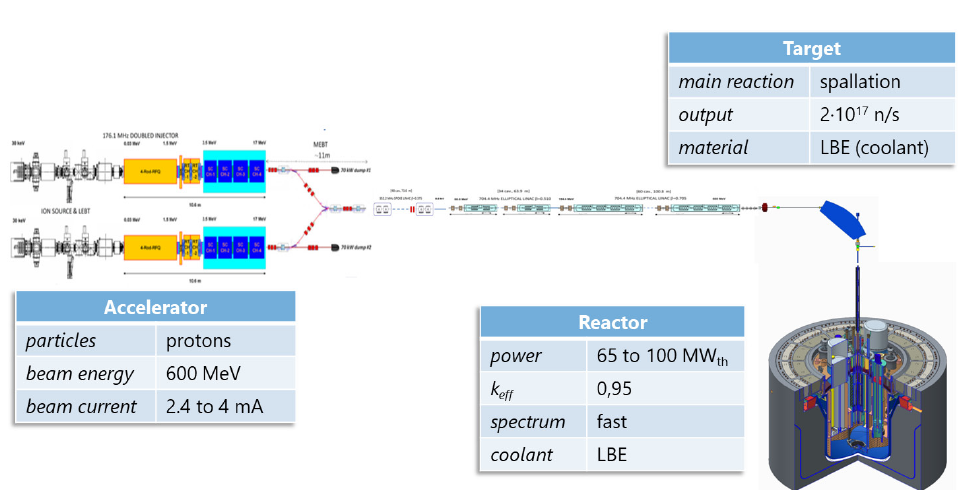
Fig. 1. – MYRRHA ADS coupling a Linac delivering 600 MeV × 4 mA proton beam in a Pb-Bi cooled sub-critical reactor of 100